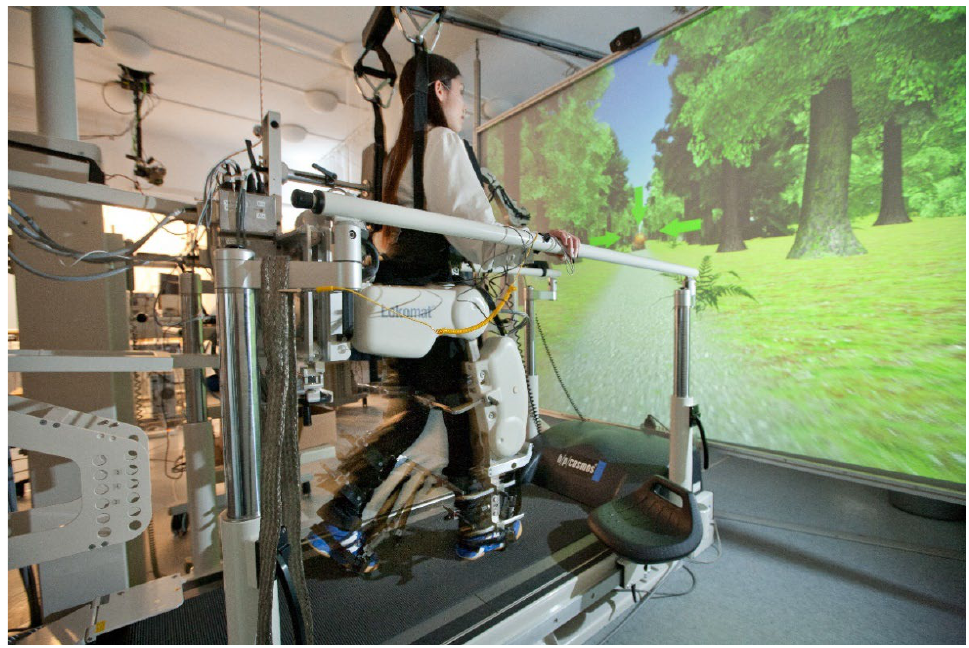
Figure 1. Lokomat exoskeleton. Source: Prof. R. Riener, ETH Zürich. For control purpose, exoskeletons are usually equipped with three different types of sensors: (1) sensors to primarily detect the internal state of the exoskeleton (e.g., inertial measurement units (IMU), joint angle encoders, torque, and force sensors), (2) sensors to detect the interaction between exoskeleton with the environment (e.g., sensorized insoles or distance sensors), and (3) sensors to directly measure the state of the user (e.g.,